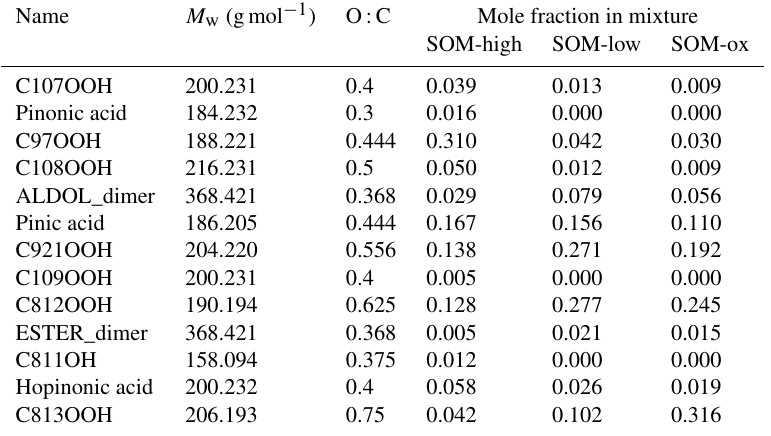
Table 2. Molecular weights (M w ), O:C elemental ratios and mole fractions of the α -pinene ozonolysis products from Zuend and Sein- feld (2012) used in the thermodynamic modeling study. Three different scenarios were investigated: high SOM concentrations (SOM-high), low SOM concentration (SOM-low) and with higher shares of the more oxidized products (SOM-ox). Name M w (gmol − 1 ) O:C Mole fraction in mixture SOM-high SOM-low SOM-ox C107OOH 200.231 Pinonic acid